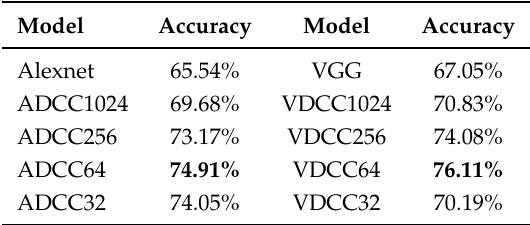
Table 4. Retrieval accuracies of the models based on Alexnet, VGG and corresponding DCC frameworks according to the P@150